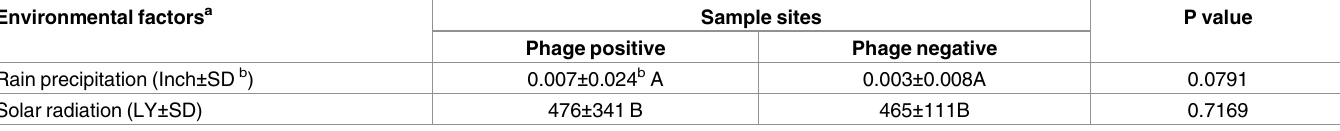
a Least-squares means were calculated within each factor, and values within each factor with the same letter (A, B) are not significantly different (P > 0.05). b Data presented are mean ± SD (standard deviation).